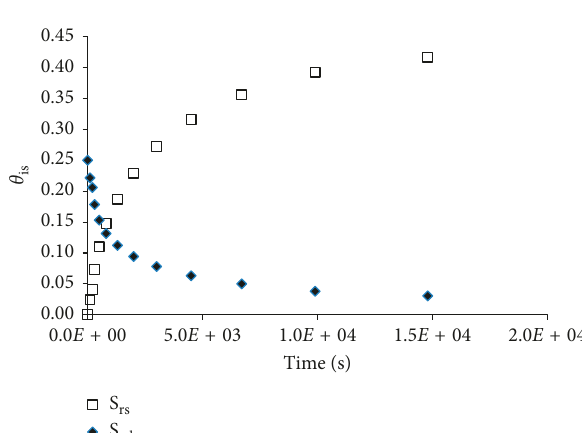
Figure 6: Variation of adsorbed sulfur (S fractions with time.